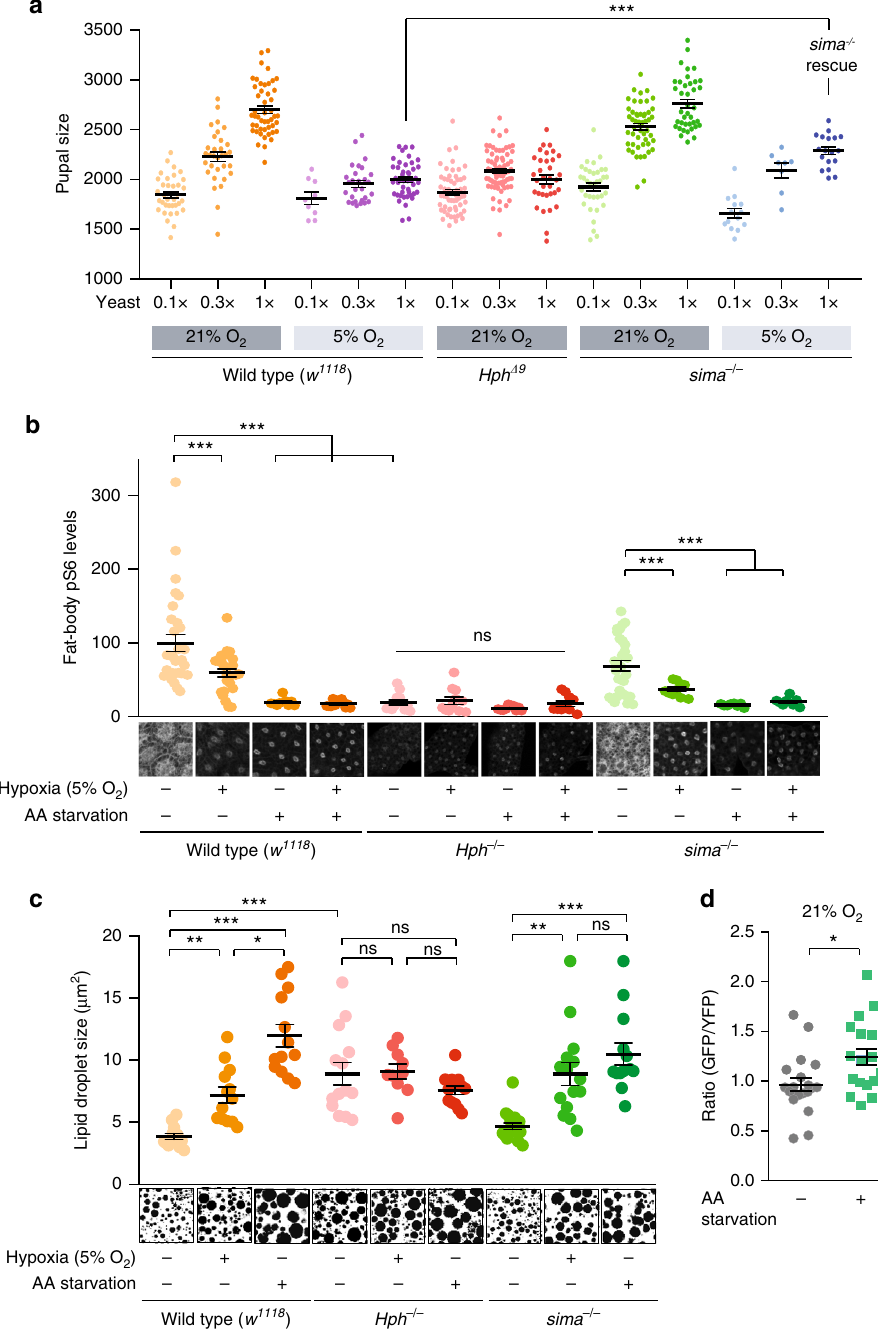
Fig. 7 Hph-dependent amino-acid and oxygen sensing via Tor is HIF-1a/Sima-independent. a Growth response to dietary amino-acid levels (0.1×, 0.3×, and standard 1× dietary yeast concentrations) of wild types ( w 1118 ) and Hph and sima mutants under normoxia (21% O 2 ) and hypoxia (5% O 2 ). Note that sima mutants are signi fi cantly larger than wild types on 1× yeast food in hypoxia, whereas their sizes are not signi fi cantly different in normoxia ( p = 0.26), further indicating that Sima is required for hypoxia-induced growth suppression. n = 8 – 71. b Fat-body staining against phosphorylated ribosomal protein S6 (anti-pS6), a downstream indicator of Tor activity, indicates that the Tor pathway is suppressed by 16 h amino acid starvation (1× sugar-only medium), hypoxia (5% O 2 ), or Hph mutation. sima mutants exhibit Tor-pathway activation under normoxia, and thus Sima is not required for Tor activity. Tor activity decreases under hypoxia and with amino-acid deprivation, indicating that Sima activity is also not required for Tor suppression. Combined treatments of amino-acid starvation and hypoxia do not further suppress Tor. Representative images of pS6 stain are shown. n = 8 – 30. c Sizes of fat-body lipid droplets examined by CARS microscopy in wild types ( w 1118 ) and Hph and sima mutants with 16 h hypoxia (5% O 2 ) or amino acid starvation (1× sugar-only medium). Lipid-droplet size increases under hypoxia and protein starvation in wild types and sima mutants, but not Hph mutants. Representative CARS images are shown. n = 10 – 18. d Hph activity re fl ects amino acid availability. Fat-body imaging of the GFP::ODD Hph-activity reporter indicates that GFP::ODD degradation is reduced under 4 h amino acid starvation (1x sugar food), suggesting that Hph activity is blocked by lack of amino acids. n = 20. Statistics: Student ’ s t -test for pairwise comparisons and one-way ANOVA with Dunnett ’ s for multiple-comparisons test. * P < 0.05, ** P < 0.01, *** P < 0.001, compared with the control. Error bars indicate SEM. Underlying data are provided in the Source Data fi